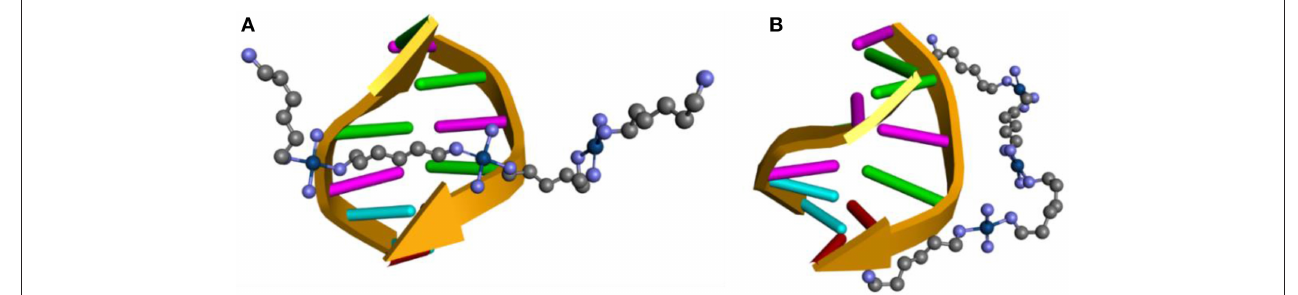
FIGURE 4 | Scheme of the interaction position between the TriplatinNC complex with DNA: (A) Model A, (B) Model B.